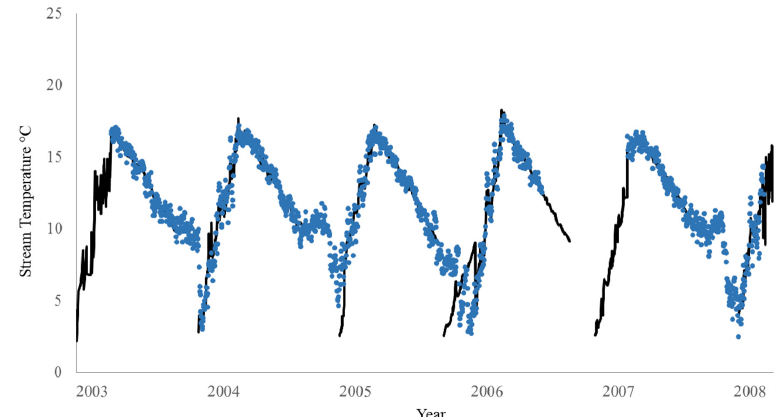
Figure 12. Observed ( blue dots ) and estimated ( black lines ) daily mean stream temperature from a site in the Middle Fork John Day River near Phipps Meadow. Estimated stream temperature is from models built using site-specific data.